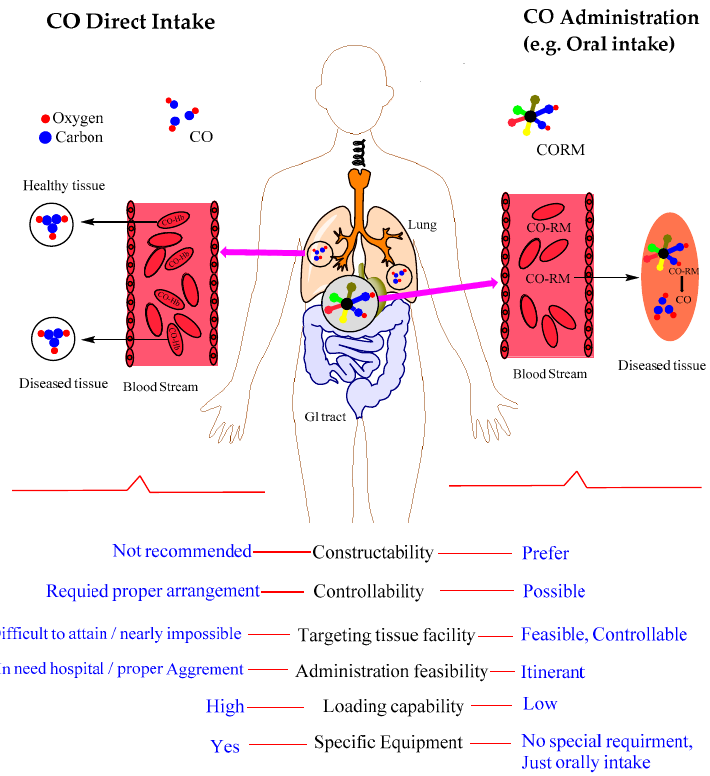
Figure 4. The feasibility analysis of the CO direct and indirect inhalation shows their different biological observance inside a human body.